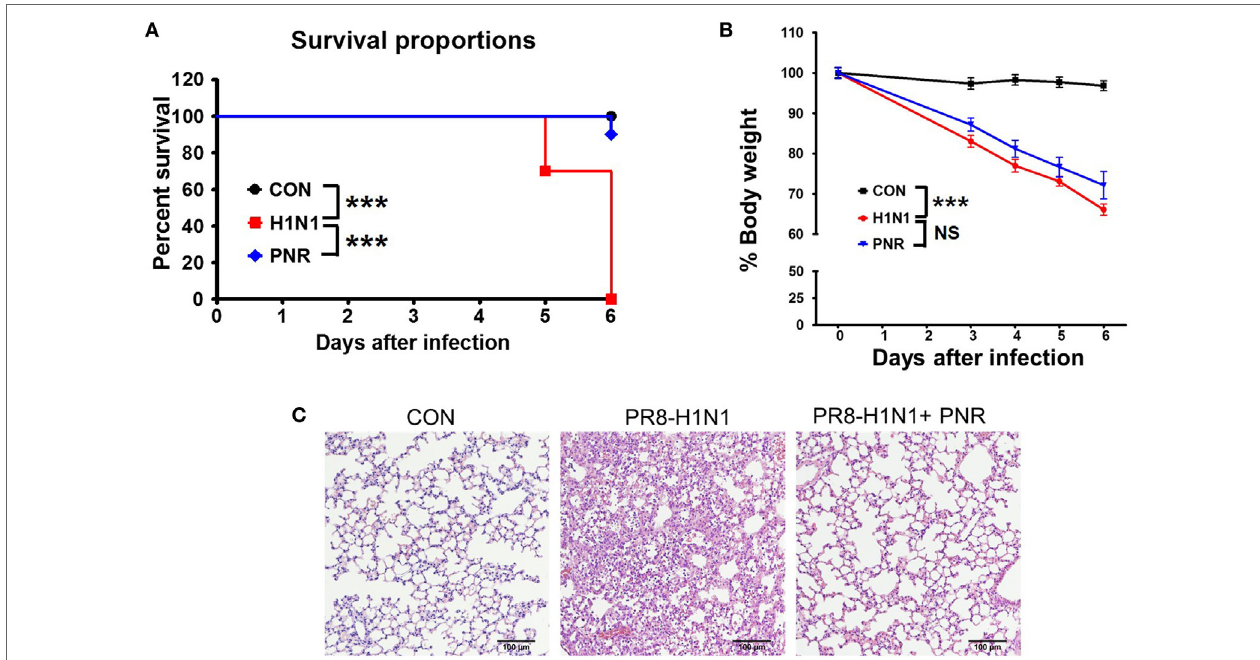
FigUre 8 | Effect of Panax notoginseng root (PNR) extract on influenza A virus infection in mice. BALB/c mice were pretreated orally with 100 mg/kg PNR (200 μ L/ mouse) water extract 1, 2, 3, 4, 5, 6, and 7 days before virus infection. (a) Percent survival and (B) body weight were monitored daily until 6 days post-infection. (c) A representative H&E image of histopathological damage in sectioned lung tissue from untreated mice or mice treated with PNR. To evaluate the significance of observed differences, the log-rank test (a) and two-way ANOVA with Bonferroni’s correction (posttest) (B) were used. *** P < 0.001, n.s., not significant. The mean and SEM are presented.